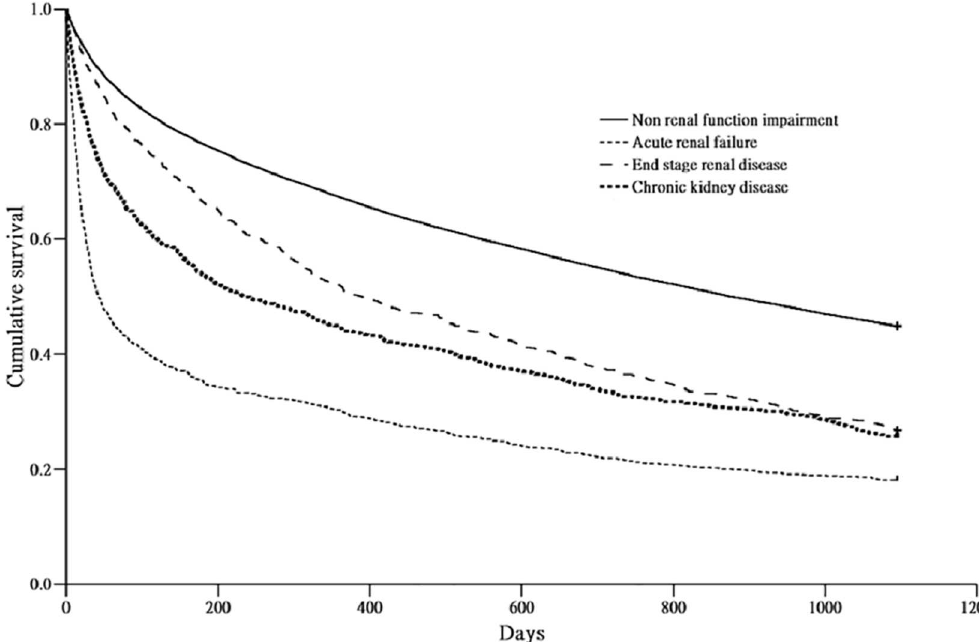
Fig 1. Cumulativesurvivalplotfor cirrhoticpatients withacuterenal failure,chronic kidney disease, and end stagerenal disease, and withoutrenal